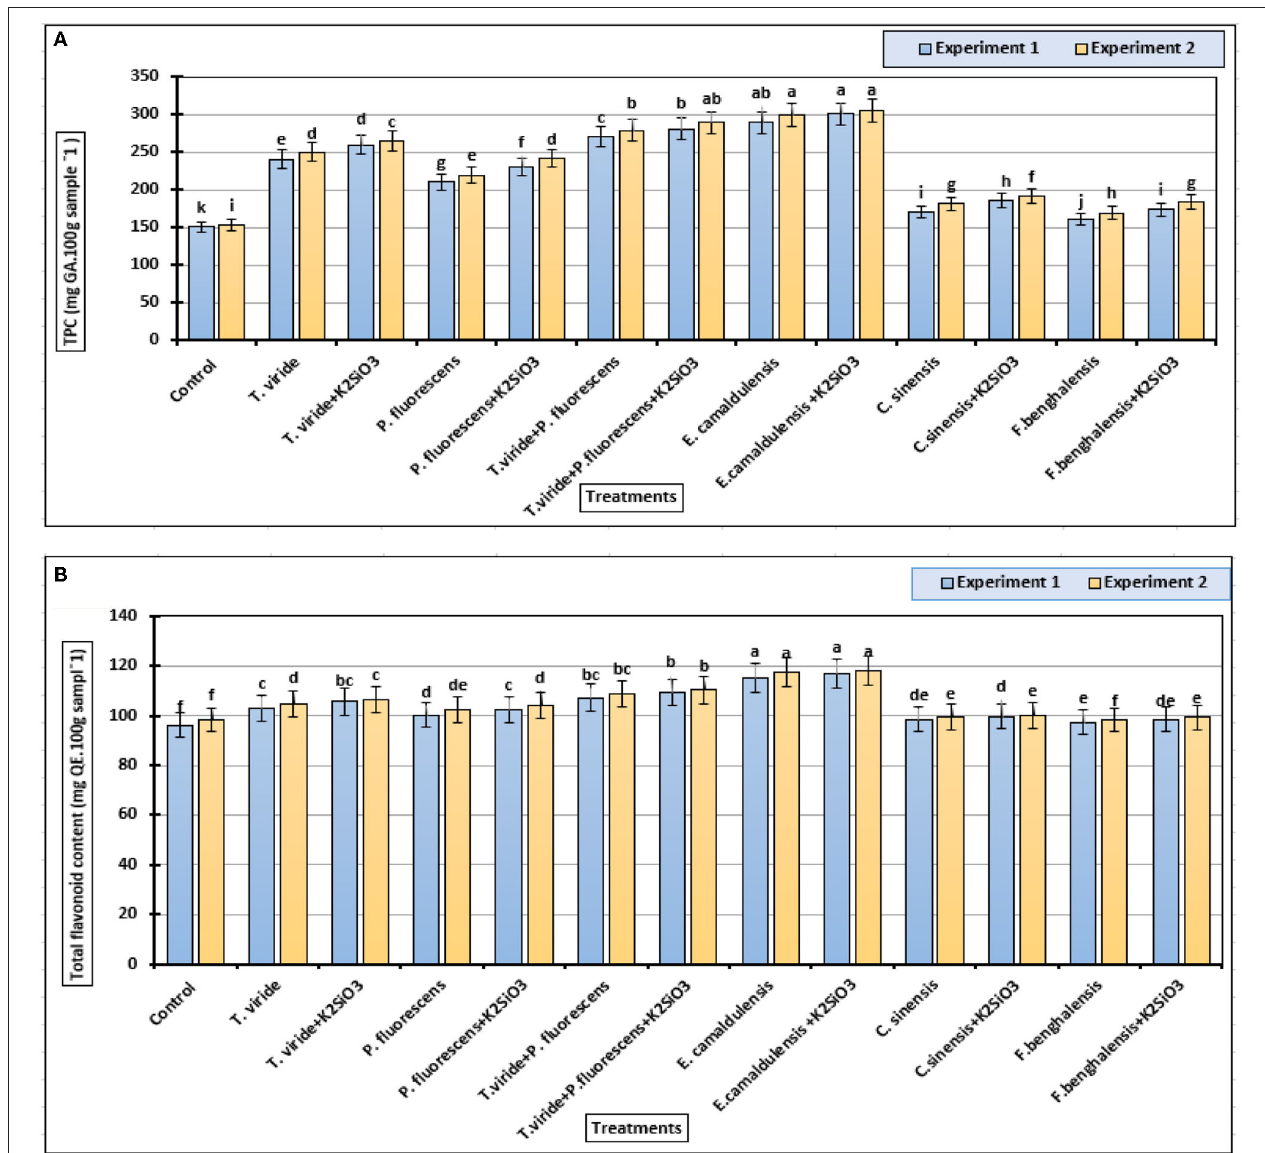
FIGURE 5 | Phenolic and flavonoid contents (means ± S.E) of zucchini fruits as affected by the plant extracts, microbial inoculations, and potassium silicate biostimulants. (A) Total phenolic content and (B) total flavonoid content. Letters in the figure indicated that the means ± S.E of treatments with the same letter/s were not significantly different according to Tukey’s HSD at a 0.05 level of